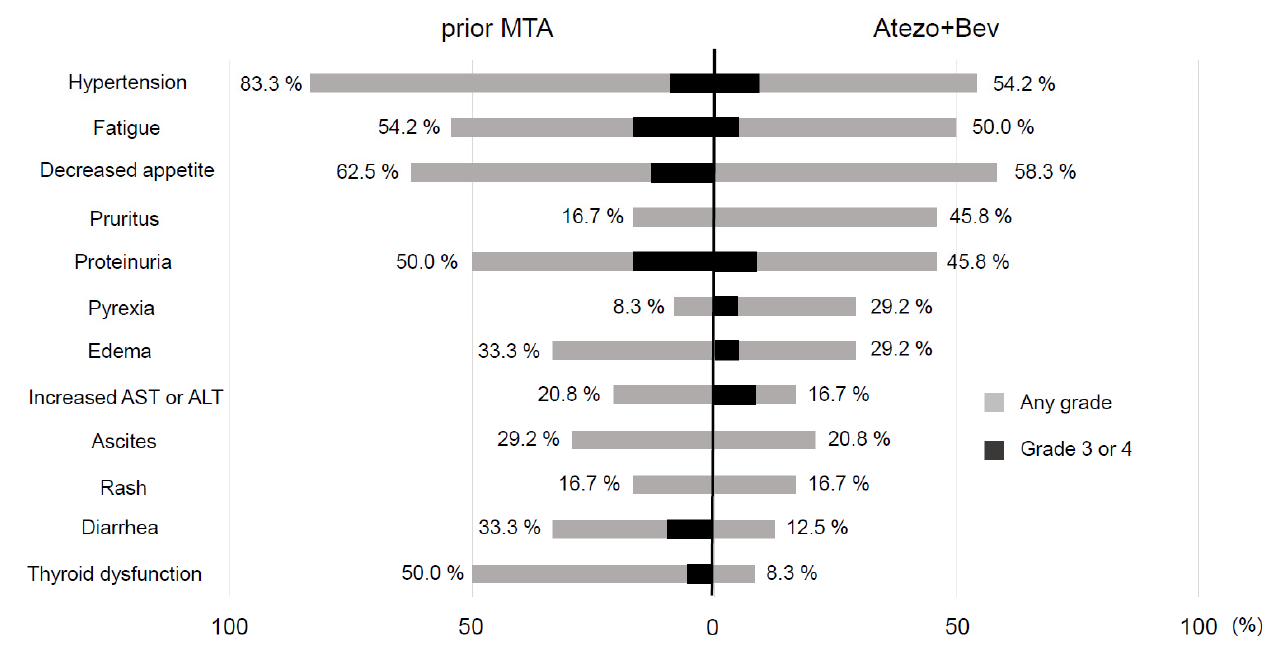
Figure 2. Comparison of adverse events between prior MTA therapy and atezolizumab plus bevacizumab. Adverse events found in >50% included hypertension, fatigue, decreased appetite, proteinuria, and thyroid dysfunction with prior MTA therapy, while hypertension, fatigue decreased appetite were seen with atezolizumab plus bevacizumab.